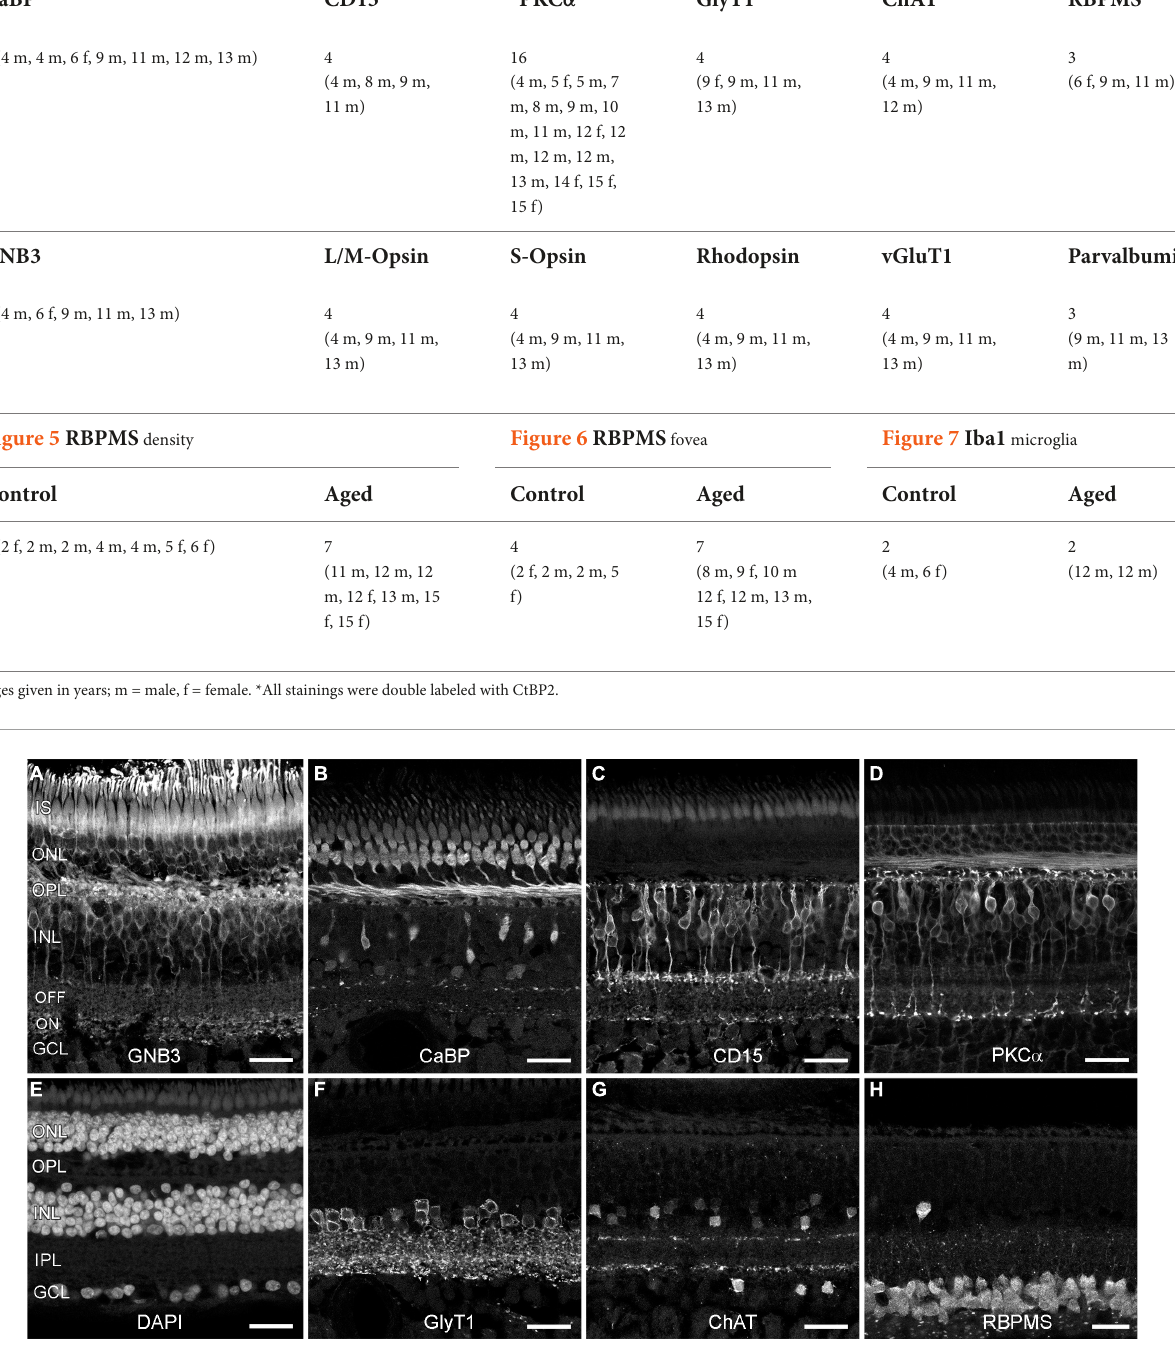
FIGURE1 Neuronal types are preserved in old marmoset retina. Shown are vertical vibratome sections through central (C,D,F–H) and midperipheral (A,B,E) retina from aged marmosets (9 and 11 years old) that were labeled with antibodies to distinct neuron types and DAPI. (A) Photoreceptors and ON bipolars cells (GNB3). (B) Cones and one OFF bipolar cell type (calbindin). (C) Flat midget bipolar cells (CD15). (D) Rod bipolar cells (PKC α ). (E) DAPI (all nuclear layers). (F) Glycinergic amacrine cells (GlyT1). (G) Starburst amacrine cells (ChAT). (H) Ganglion cells (RBPMS). IS, inner segments; ONL, outer nuclear layer; OPL, outer plexiform layer; INL, inner nuclear layer; IPL, inner plexiform layer; GCL, ganglion cell layer. Scale bars, 25 µ